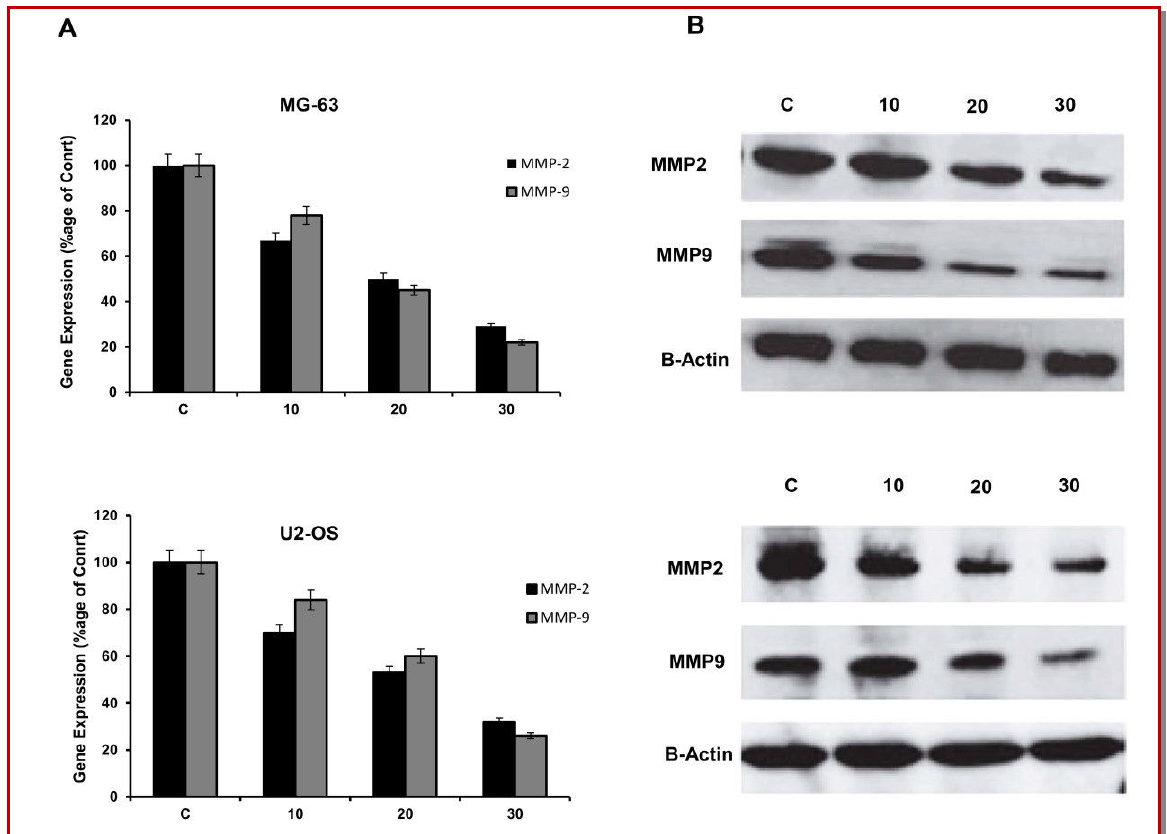
Figure 4: The mRNA (A) and protein levels (B) in withaferin A-treated cells were assessed using real-time RT-PCR and western blot analysis, respectively GAPDH was used to normalize the mRNA level. The results are presented as the percentage relative to control. β - Actin was used as a sample load- ing control. The expression of MMP-2 and MMP-9 genes both at the mRNA and protein levels was dose-dependently reduced with withaferin A